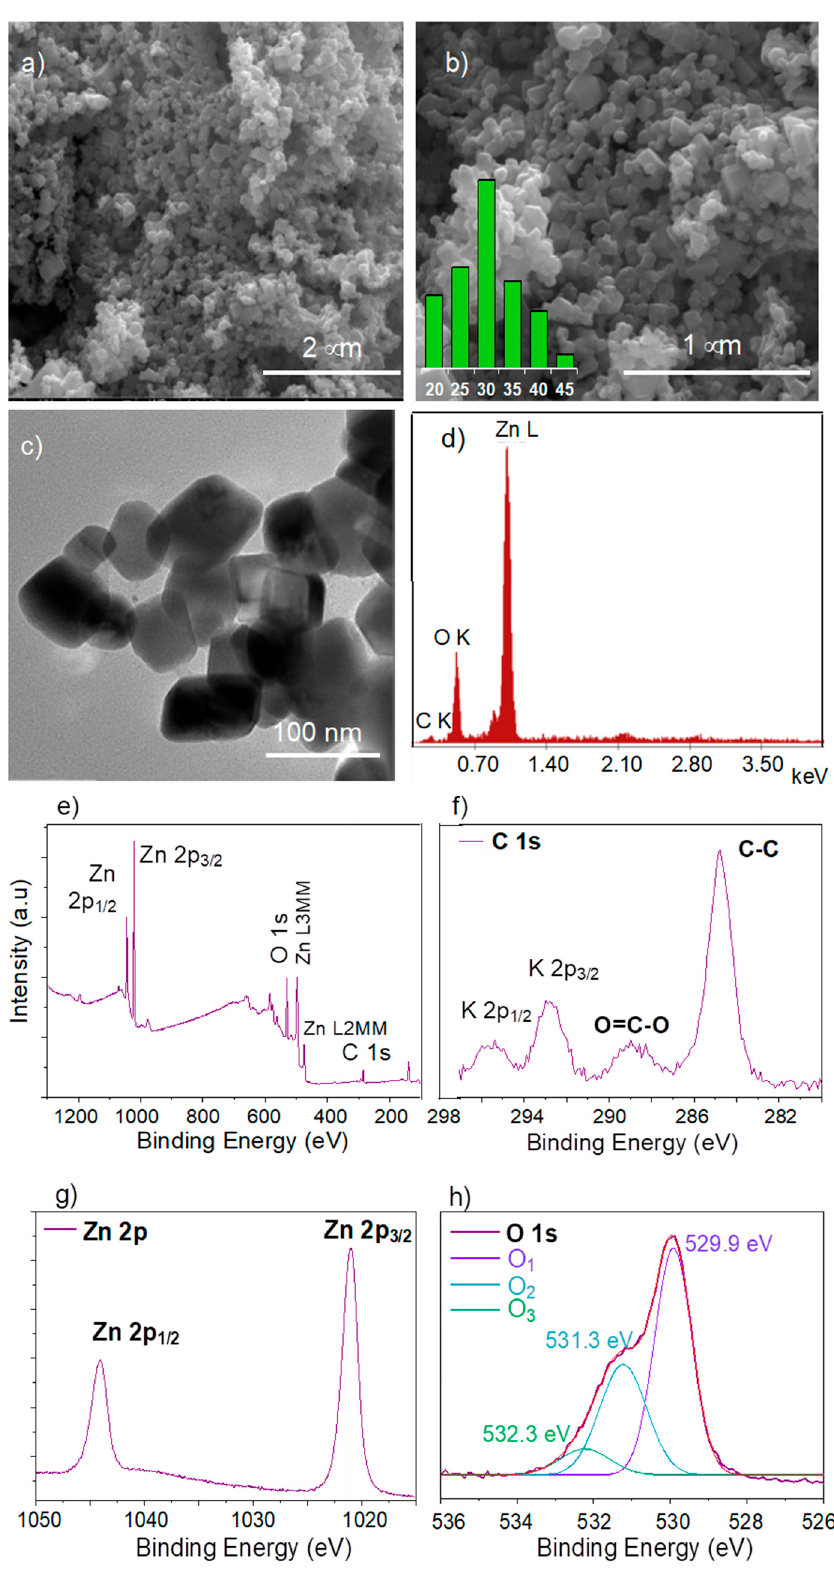
Figure 3. Electron microphotographs at 40,000 × ( a ); and 80,000 × magnification (the inset size distribution histogram was calculated from SEM analysis at 100,000 × magnification) ( b ). TEM image ( c ) and Energy dispersion spectrum (EDS) of ZnO nanopowders ( d ). X-ray photoelectron spectroscopy of ZnO nanoparticles: survey wide spectrum ( e ) and C 1s ( f ), high-resolution spectra of Zn 2p ( g ) and O 1s ( h ).